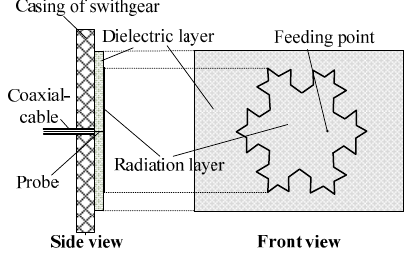
Figure 1. Structure of the built-in antenna sensor.